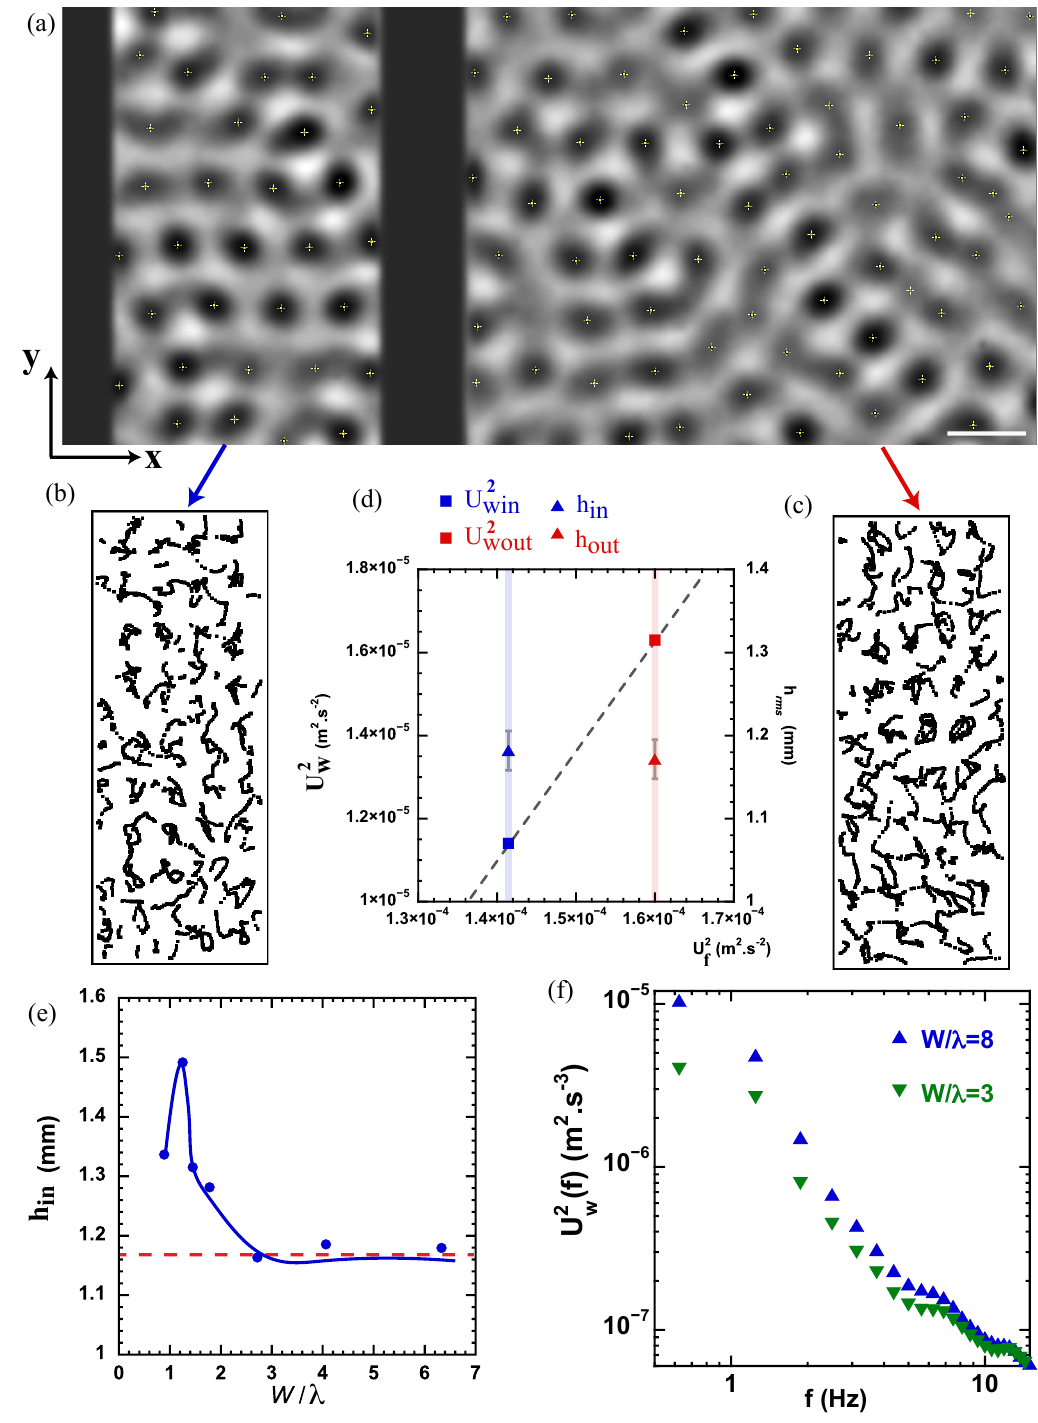
Figure 2. ( a ) An image of the Faraday waves using the diffusive light imaging technique. Peaks and troughs appear as dark and white blobs. Local wave maxima are detected (white crosses within the dark blobs), and their motion is tracked using PTV techniques (scale bar = 10 mm). ( b , c ) trajectories of the wave peaks tracked over 50 Faraday wave periods; ( d ) variance of the wave horizontal velocity U 2 w and r.m.s wave elevation h versus the turbulent flow energy U 2 measured inside (index in , blue f color) and outside (index out , red color) of the cavity; ( e ) r.m.s value of the wave amplitude h in measured in the cavity versus gap width W / λ at fixed vertical acceleration a = 1 g. The red dotted line indicates the r.m.s value of the wave amplitude in the unbounded domain; ( f ) Frequency power spectrum of the fluctuations of the wave horizontal